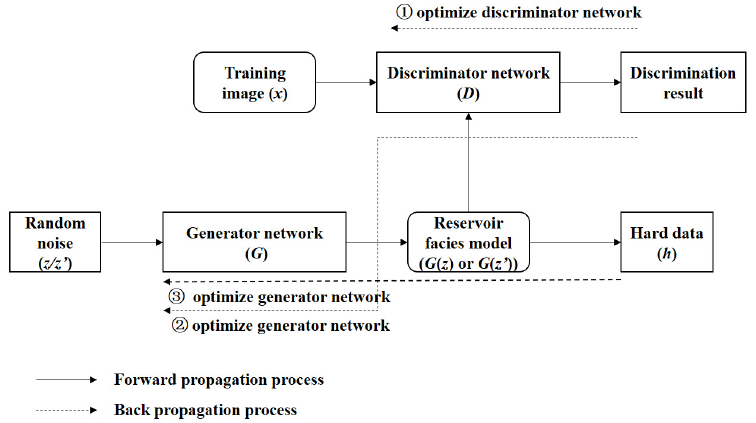
Figure 6. Schematic diagram of the improved method of unconditional simulation modeling and conditional simulation modeling based on GANs.